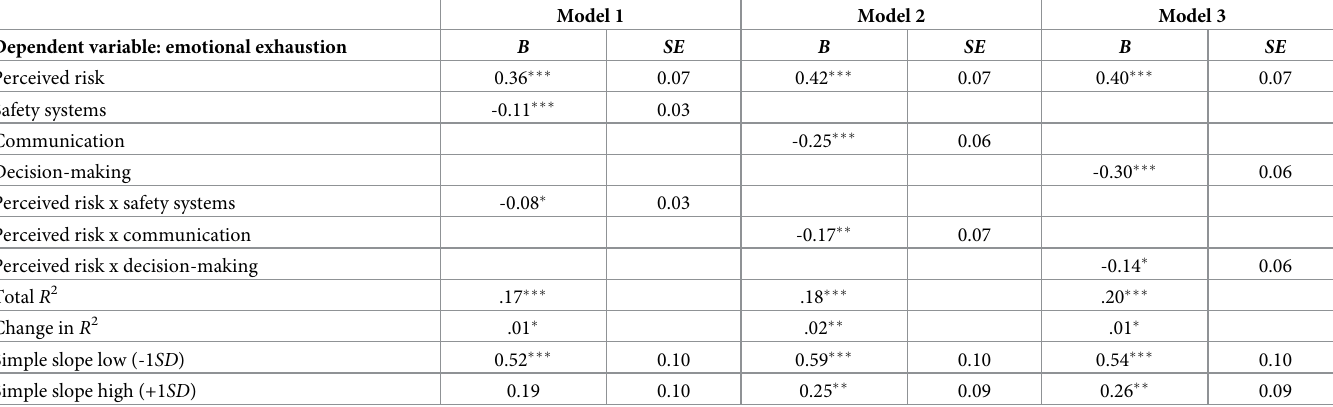
Table 2. Results from moderated multiple regression analyses: Model 1, Model 2, and Model 3 ( N = 358).